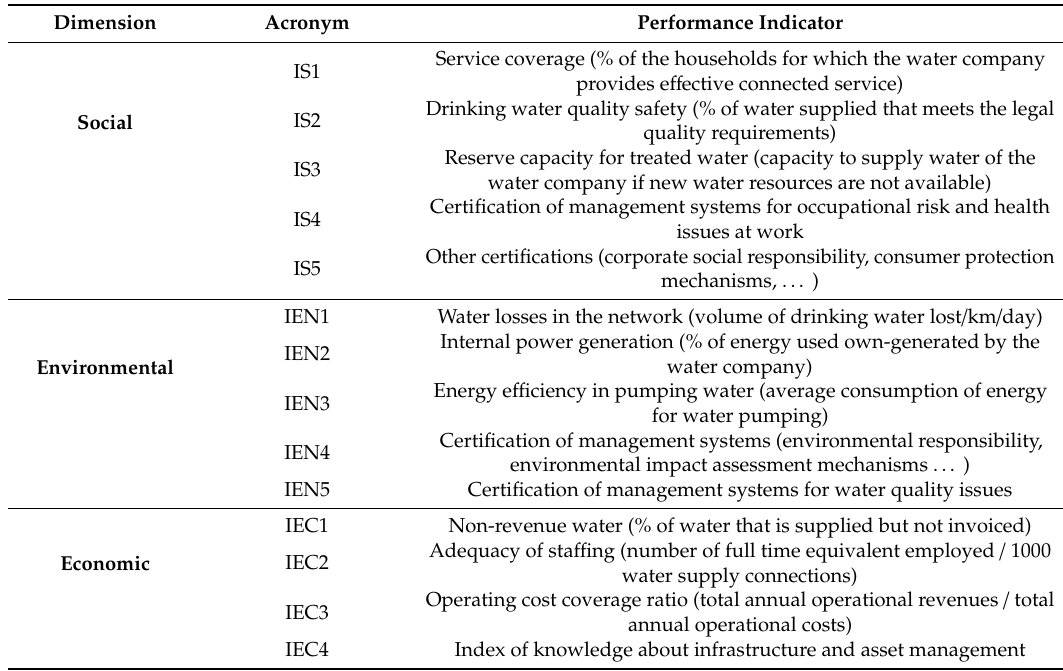
Table A1. Initial set of